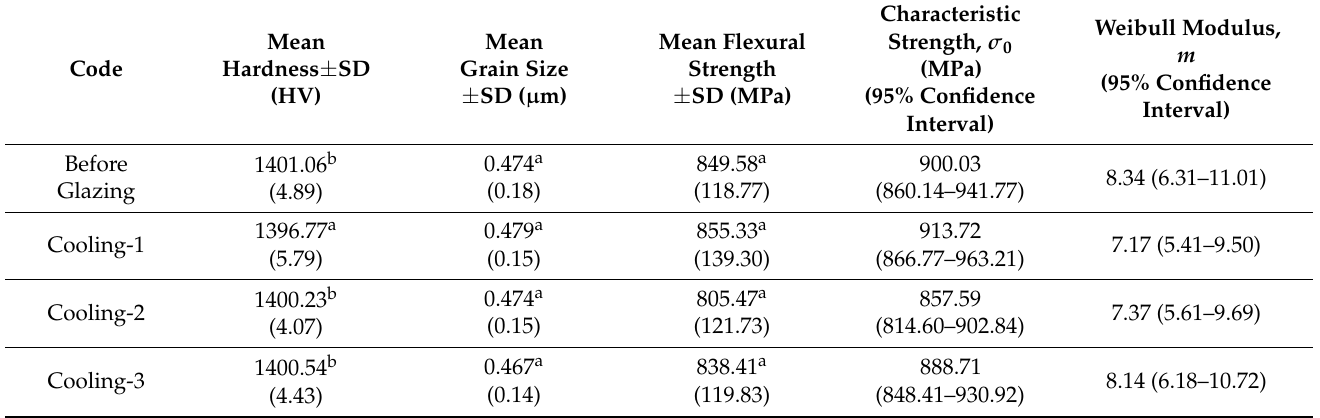
Table 3. Hardness value, grain size, flexural strength, characteristic strength, and Weibull modulus for each group of the zirconia